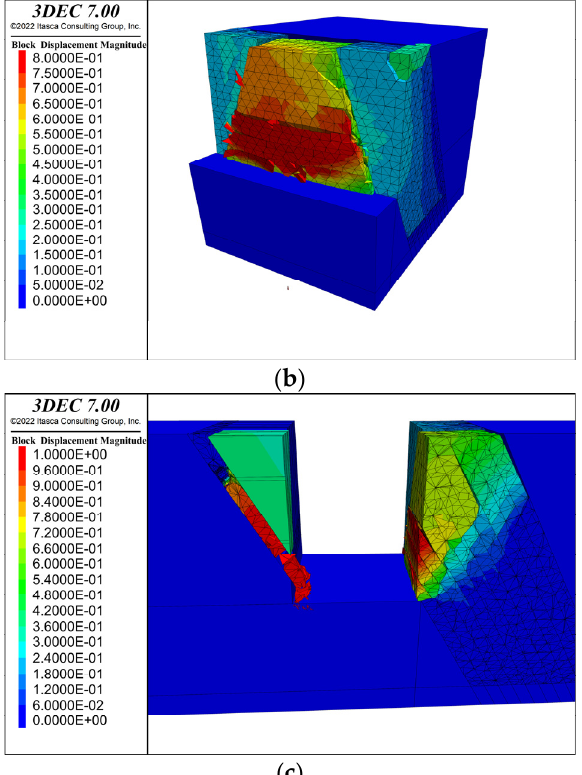
Figure 3. Cross-sectional view of failure mode of rock mass within 50 m length of foundation pit under 60° dip angle of structural plane. ( a ) failure mode of the foundation pit on the bedding rock side; ( b ) failure mode of the foundation pit on the toppling rock side; ( c ) section view of failure mode of the foundation pit.